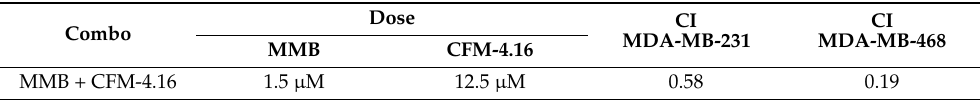
Table 2. The selected synergistic point in MMB + CFM-4.16 combination with its CI in both MDA- MB-231 and MDA-MB-468 where MMB is